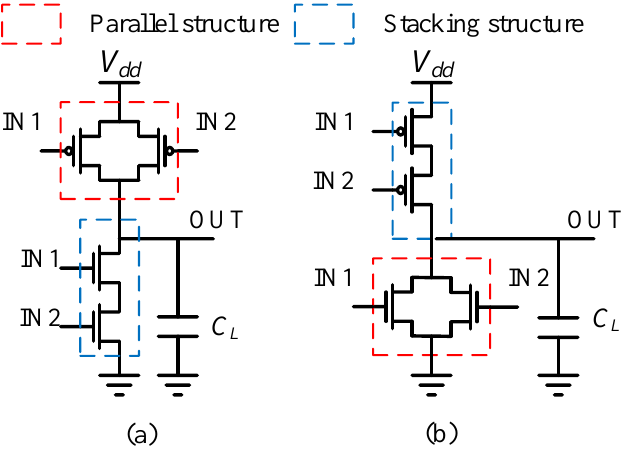
Figure 5. Parallel structure and stacking structure for ( a ) NAND gate and ( b ) NOR gate.